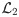
Control experiments introducing malfunction in temporal dynamics of the network.The layout of the figure in each column is similar to that of Fig 3 showing model response to different stimuli. The leftmost column remove neural adaptation, middle column removes L2-slow neurons and rightmost column removes the L3 temporal coherence.